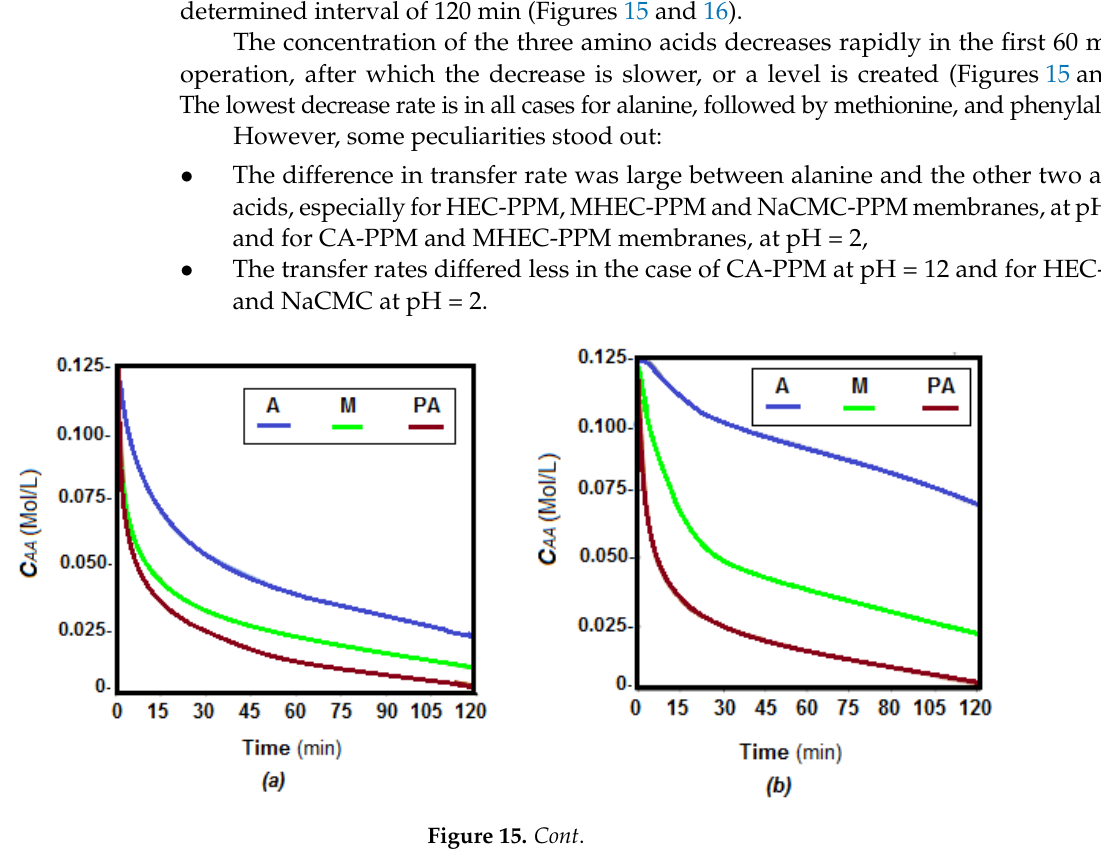
Figure 15. Variation of source phase amino acid concentration depending on the operating time at pH SP = 12 and pH RP = 7: ( a ) CA–PPM; ( b ) HEC–PPM; ( c ) MHEC–PPM; ( d ) NaCMC–PPM. A = alanine (blue); M = methionine (green) and PA = phenylalanine (brown).